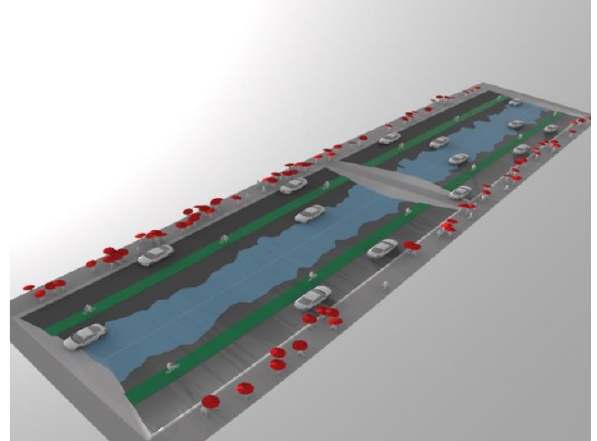
Figure 4: Shows how stormwater detention methods could radically alter streetscape configurations to accommodate future flood events. Image credit. Nano